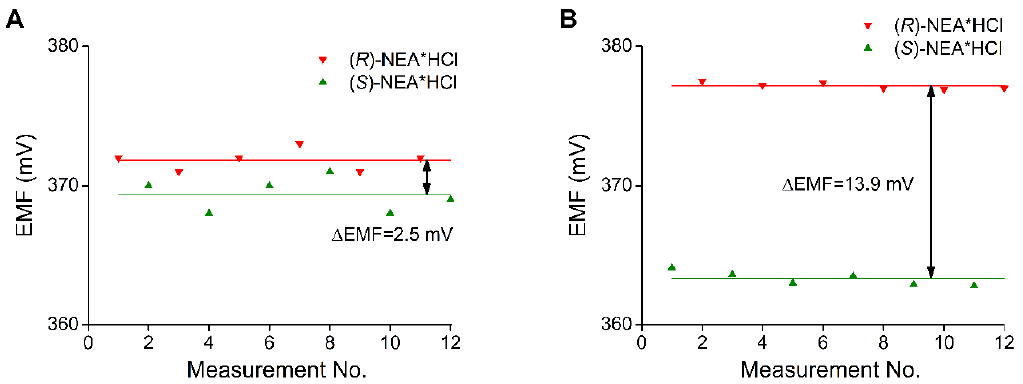
Figure 13. Measured electromotive force (EMF) values of ionophore ( R , R )- 1 ( A ) or ( R , R )- 2 ( B ) containing ion-selective membranes in the presence of enantiomers of NEA ( 21 ).